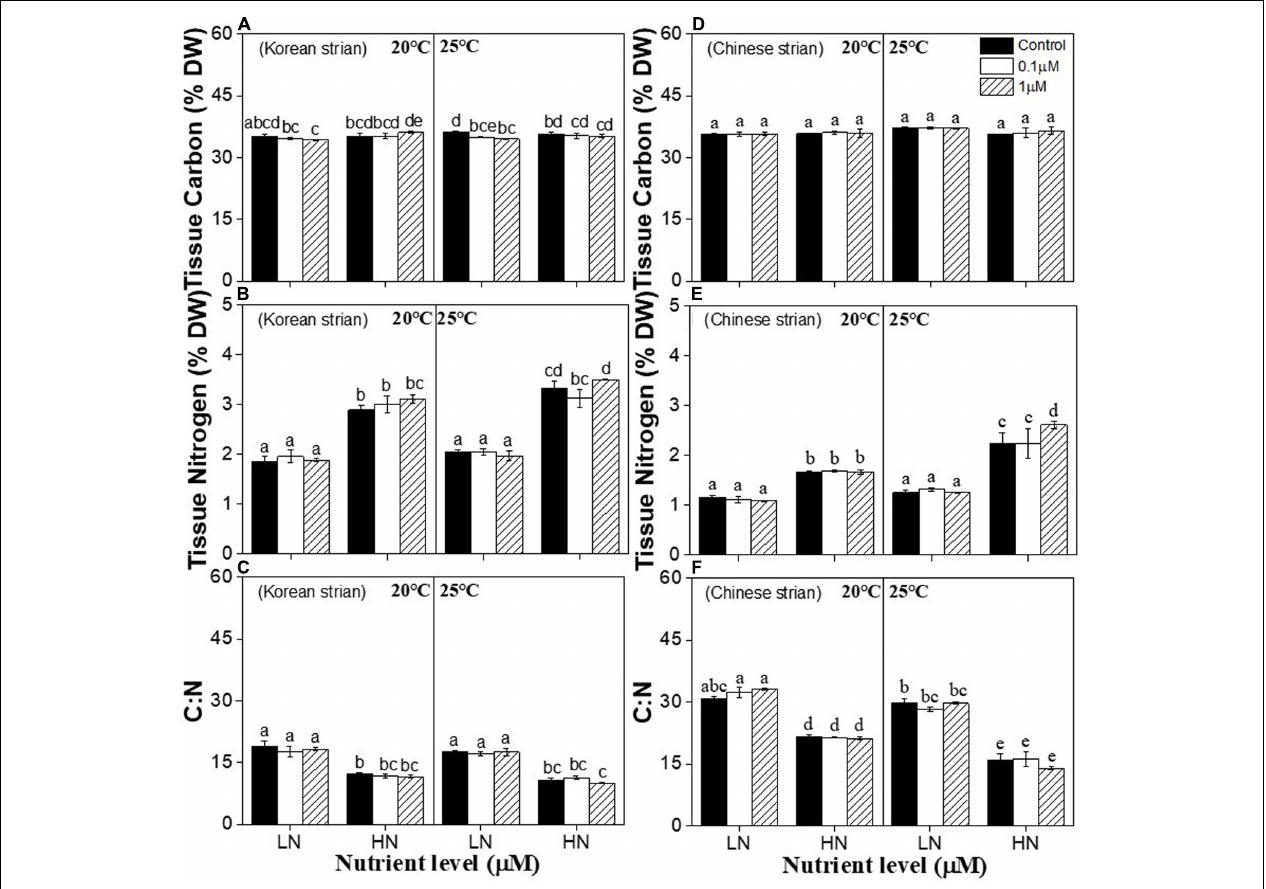
FIGURE 5 | Tissue contents in a Korean strain [Tissue Carbon (A) ; Tissue Nitrogen (B) ; C:N (C) ] Chinese strain [Tissue Carbon (D) ; Tissue Nitrogen (E) ; C:N (F) ] and of Ulva prolifera cultivated under various experimental conditions. The error bars represent the standard deviation ( n = 3). Low nutrient = 50 µ M nitrate and 5 µ M phosphate (LN); high nutrient = 250 µ M nitrate and 25 µ M phosphate (HN). Different letters above the error bars represent statistical significance ( P < 0.05) among different